Question: What kind of plot is shown here?
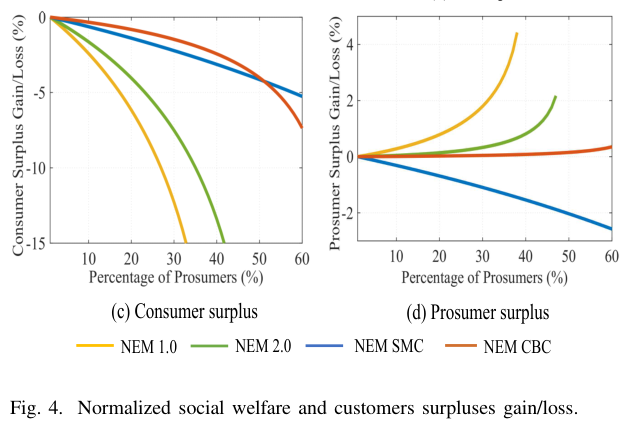
Answer: line